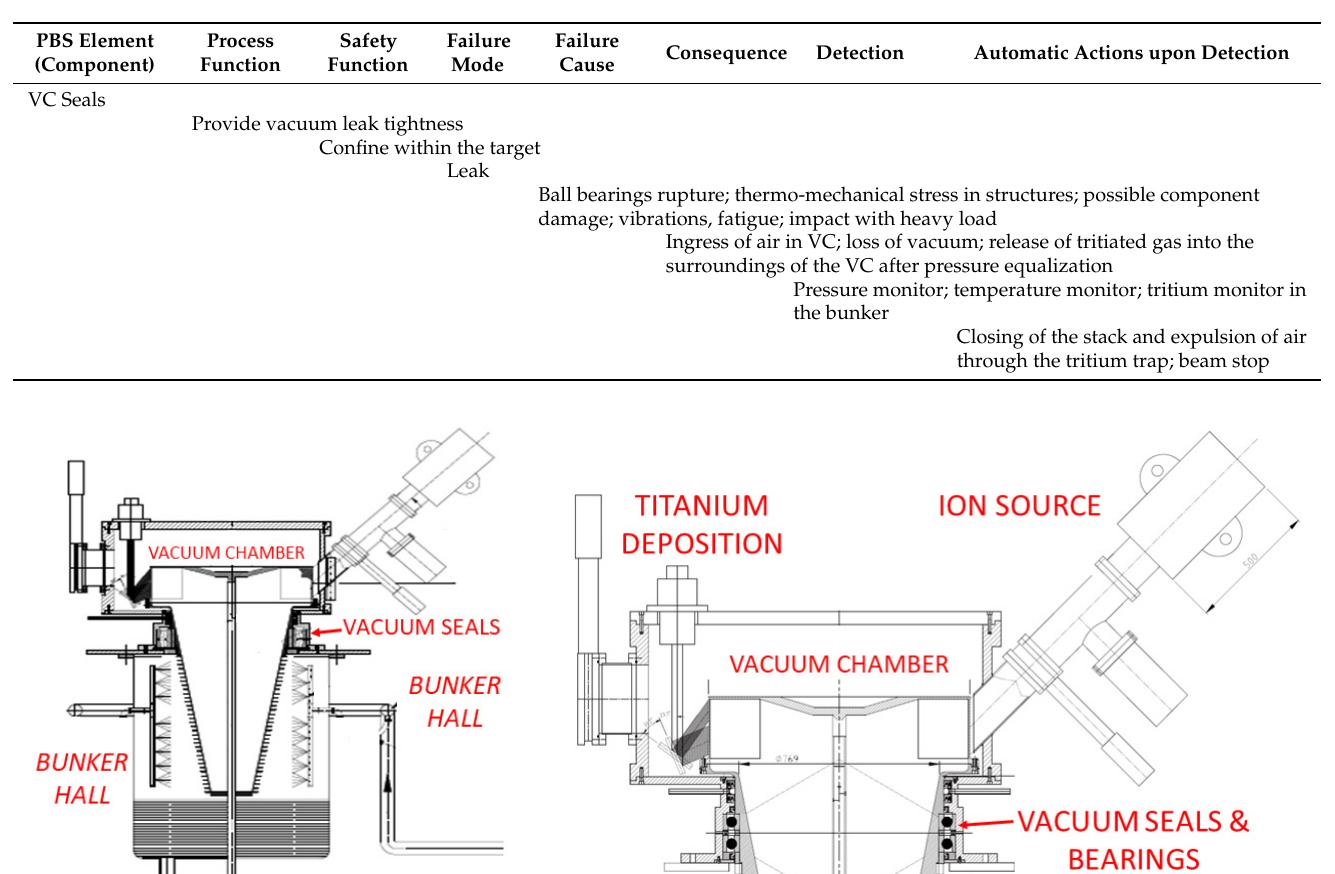
Table 1. FMEA of the seals for the vacuum inside the VC.